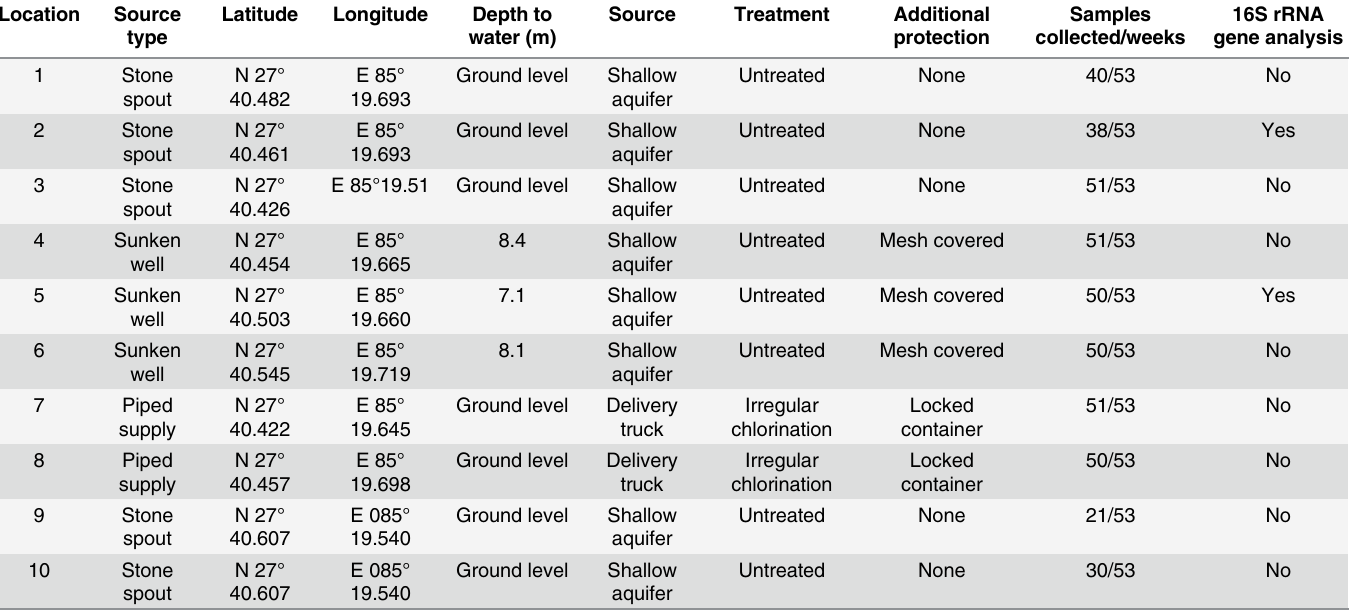
Table 1. Water sampling locations in this